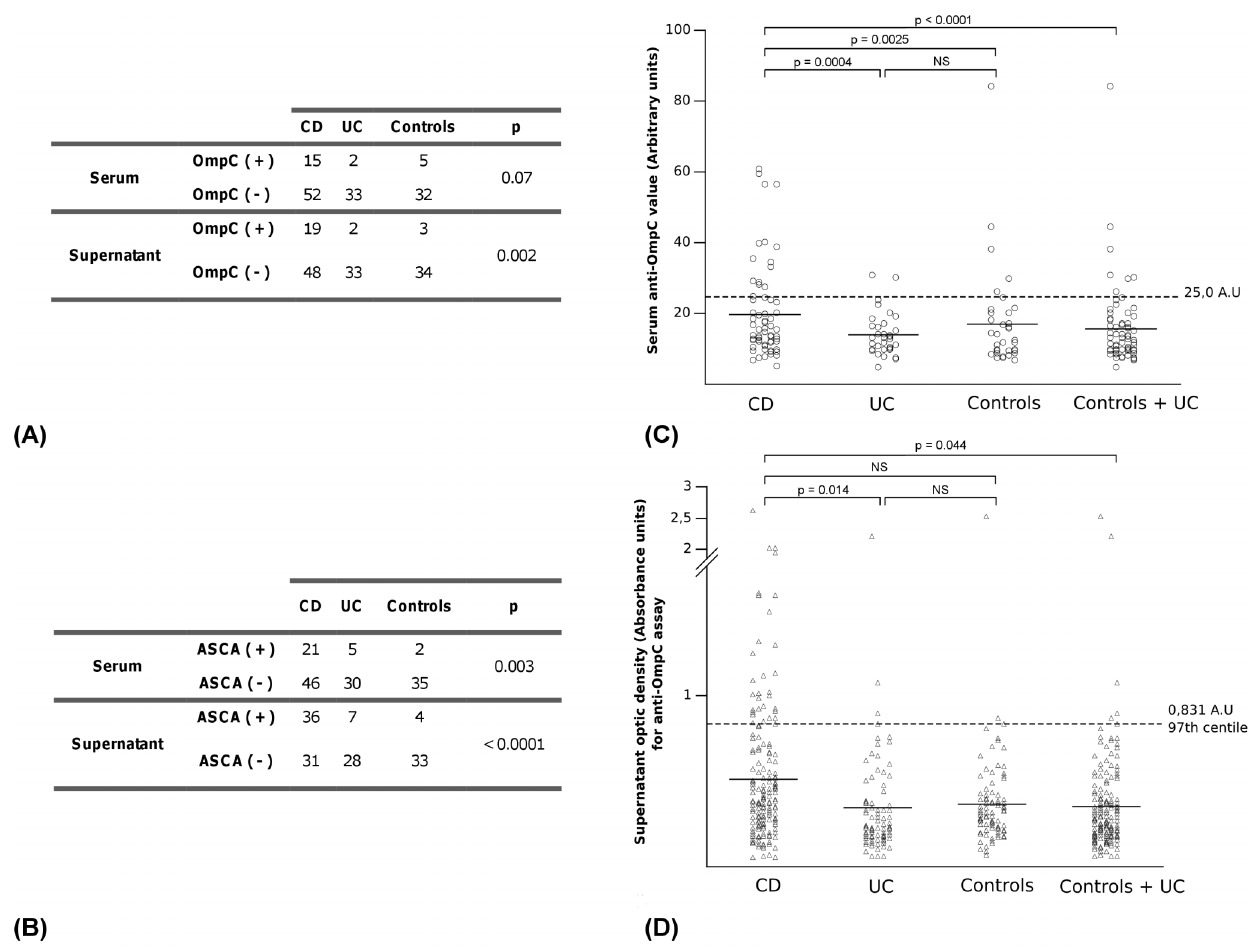
Figure 1. ASCA and anti-OmpC detection in sera and supernatants for each clinical group. (A) Qualitative results of anti- Saccharomyces cerevisiae antibodies (ASCA) test by IFI in sera and supernatants for each clinical group. One patient is considered as ASCA positive in case of positivity of ASCA IgA and/or ASCA IgG. (B) Anti-outer membrane porine C antibodies (anti-OmpC) detection by ELISA in sera and supernatants for each clinical group.(C) Distribution of anti-OmpC antibody levels in patient sera. According to manufacturer recommendations, anti-OmpC antibody levels obtained with ELISA are considered as significant when superior or equal to 25 arbitrary units (A.U). (D) Distribution of optical densities (O.D) obtained with anti-OmpC ELISA in patient supernatants issued from culture of colonic tissues. The threshold of positivity (0.831 absorbance units) is the 97th centile of the O.D obtained for the controls + UC group. NS: no statistically significant difference. The comparison between different groups is done using the Student’s t-test with p=0.05 as significance level. CD: Crohn’s disease, UC: ulcerative colitis, Controls: patients suffering from functionnal intestinal disorders but not from CD or UC.